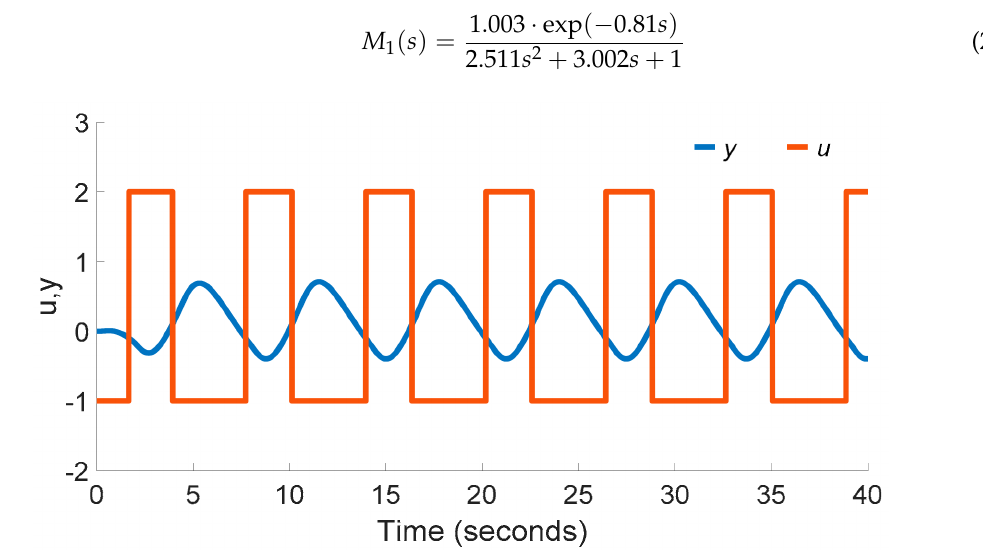
Figure 6. The relay output u and the observed output y of the process P 1 ( s ). The Nyquist frequency responses of process P 1 ( s ) and model M 1 ( s ) are shown in Figure 7. In the same figure, model M S ( s ) and the points G (0), G ( j ω 1 ), and G ( j ω 2 ) are depicted as well, where